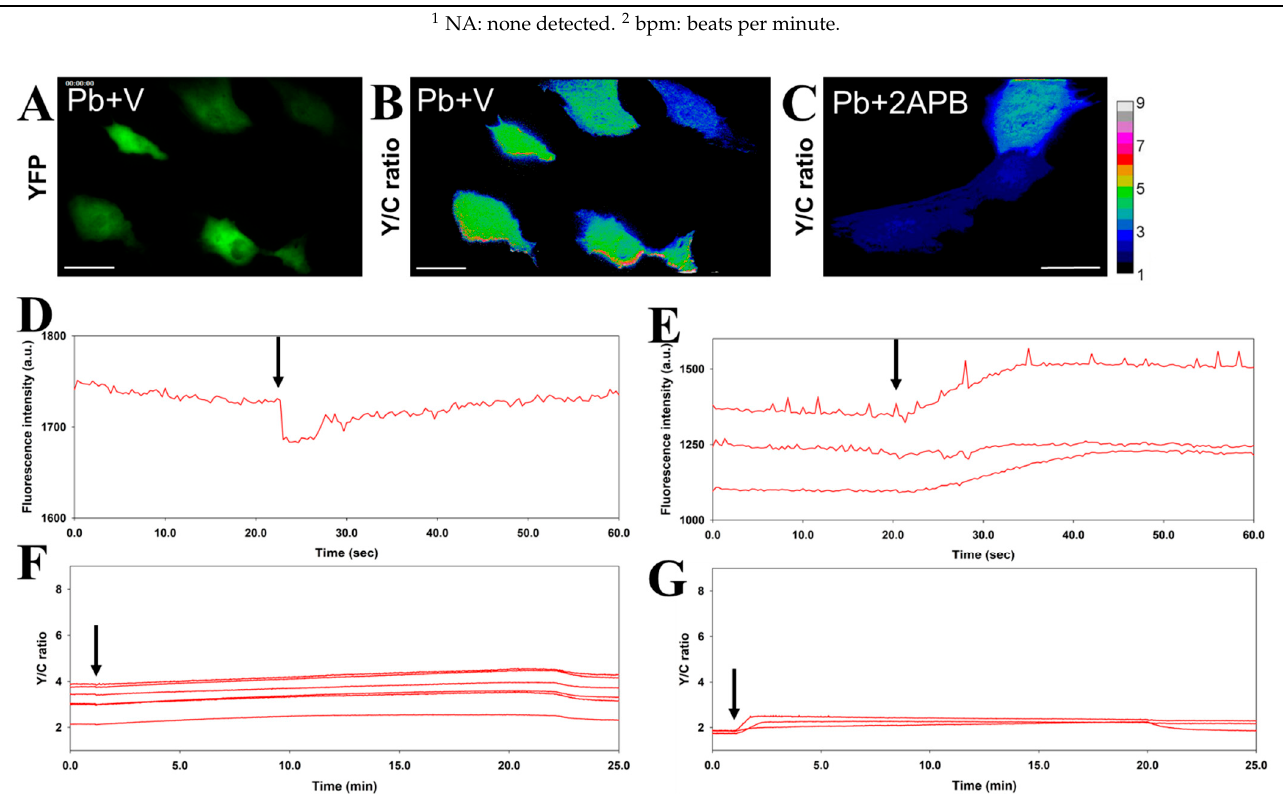
Figure 3. Assessment of the differential effects of Ca 2+ blockers on iPSC-derived cardiomyocytes by the simultaneous recording of beating activity and Pb sensing. ( A – C ), The acceptor (YFP) image ( A ) and the FRET Y/C ratio images ( B , C ) of cells expressing Met-lead 1.44 M1 were acquired in Pb buffer with verapamil (Pb + V; ( A , B )) or in Pb buffer with 2-aminoethoxydiphenyl borate (2-APB) (Pb + 2APB; ( C )). The color bar for B and C represents Y/C ratio values from 1 to 9. The scale bars are 40 μ m. ( D , E ), During the 25-min recordings, the time-lapse fluctuation in fluorescence signals in the tested cells revealed the beating activity ( D , E ). ( F , G ), Intracellular Pb sensing can be observed for Pb in the presence of verapamil ( F ) and for Pb in the presence of 2-APB ( G ). Pb (50 μ M) was introduced at the time points indicated by arrows. Table 1. Intracellular entry of Pb (FRET ratio changes) and the physiological impact of Pb (beating rate) on iPSC-induced cardiomyocytes. The original data were extracted from Figures 2 and 3. The beating frequency was described in Figure S4.